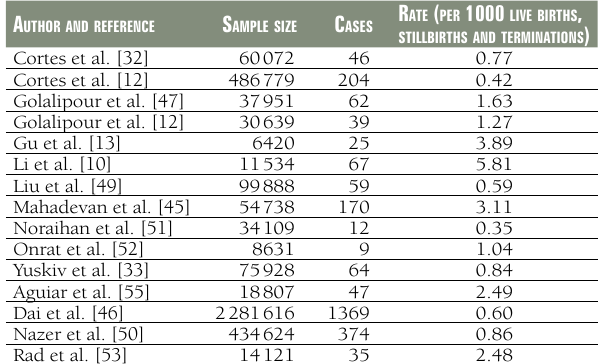
Table 9. Studies that reported rates for the burden of spina bifida based on live births, stillbirths and terminations of pregnancy a utHor aNd refereNCe s ample size